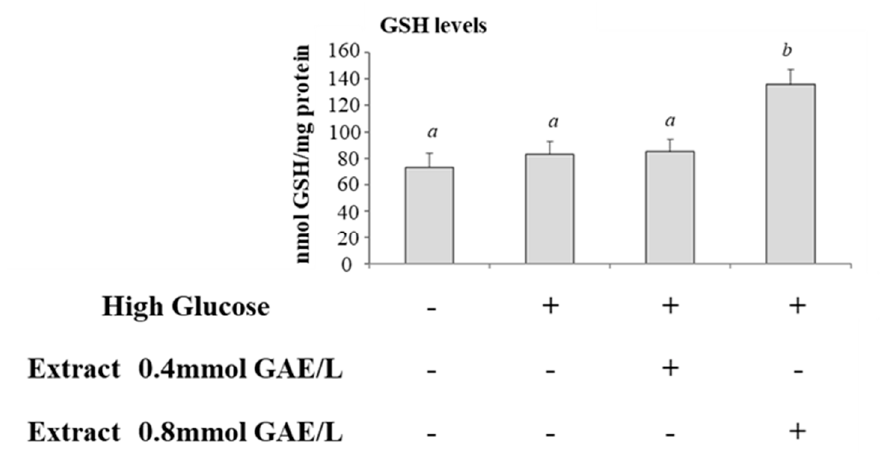
Figure 4. Glutathione level in HG-treated CaCo-2 cells in the absence or in the presence of apple polyphenolic extract Glutathione (GSH) level in control cells (25 mM glucose, Ctrl) or high glucose treated cells (50 mM glucose) incubated in the absence (HG) or in the presence of apple polyphenolic extract (0.4 and 0.8 mmol GAE/L). Results are represented as mean ± SD of 5 determinations carried out in triplicate. Different letters a,b indicate significant differences between samples ( p < 0.05).